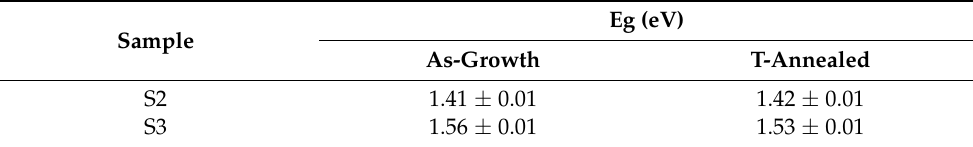
Table 2. Optical bandgap of SnS thin films before and after air annealing.